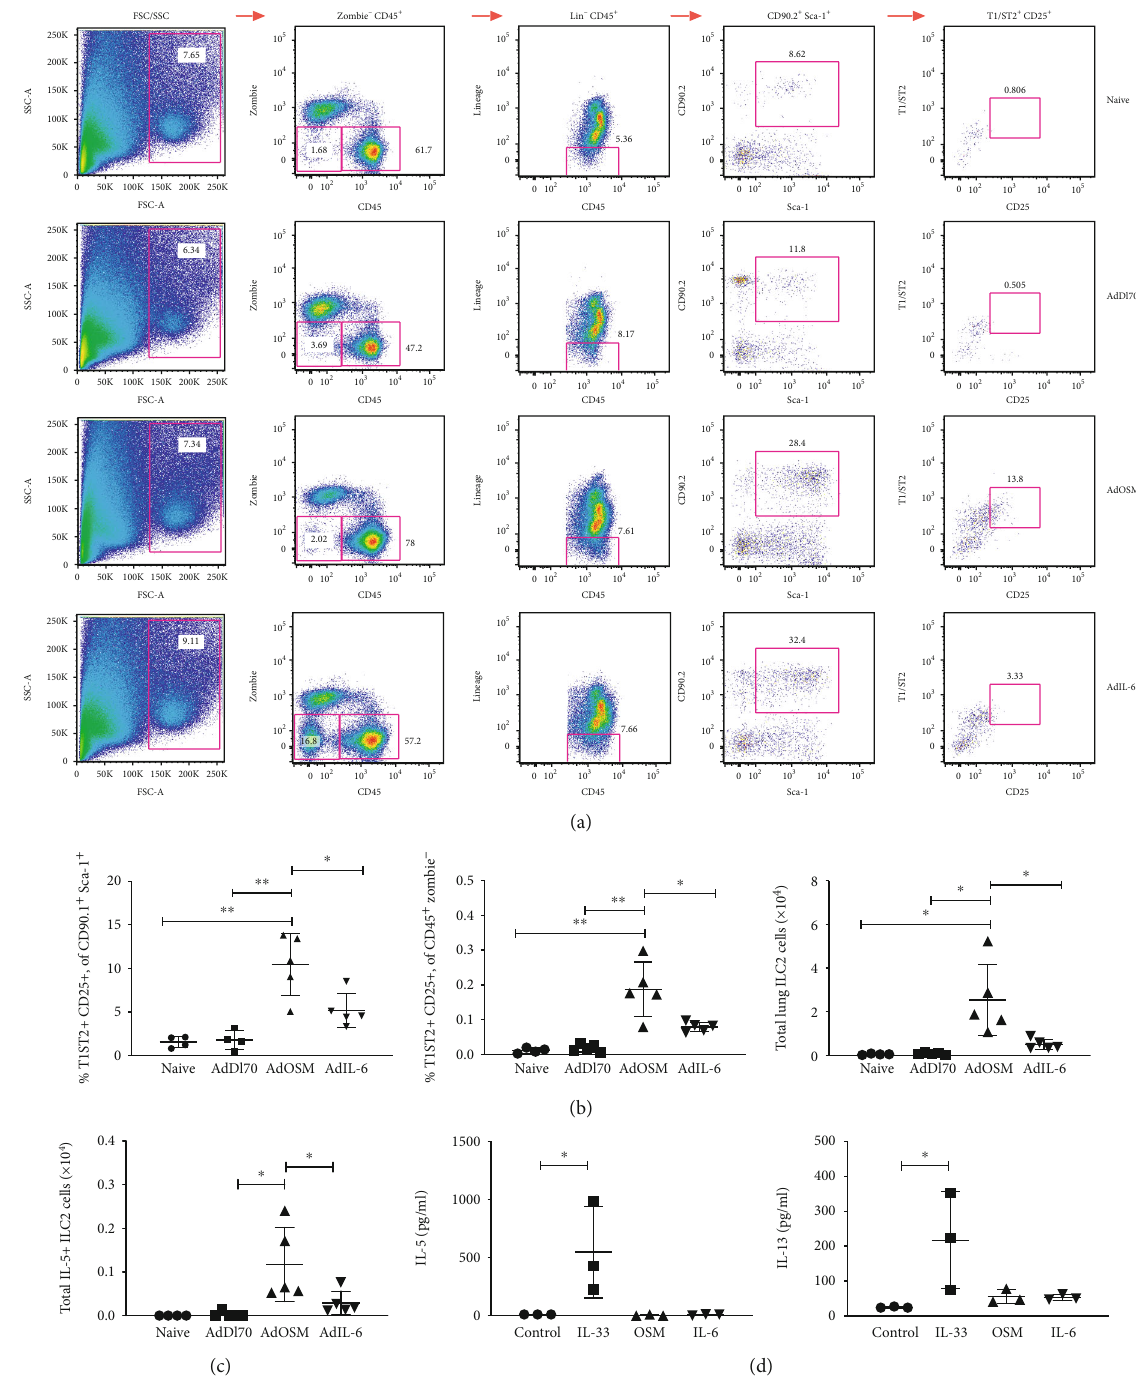
Figure 5: AdOSM, but not AdIL-6, stimulates accumulation of CD25+ T1/ST2 ILC2 cells. C57Bl6 mice were endotracheally administered AdDl70 (control), AdOSM, or AdIL-6, sacri fi ced at day 7, and ILC2 cell accumulation examined by fl ow cytometry of whole lung cells. ILC2 cells were assessed by fl ow cytometry as being lineage-negative (CD3-, CD19-, NK1.1-, Ter119-, CD11b-, and F4/80-), CD45+, CD90.2+, Sca-1+, and T1/ST2+ (IL-33R) cells that expressed varying levels of CD25. (a) Representative fl ow cytometry plots showing gating strategy for detecting T1/ST2+ CD25+ ILC2 cells from naive, AdDl70, AdOSM, or AdIL-6 infected mice. (b) Frequency of T1/ST2+ CD25+ CD90+ Sca-1+ parent and T1/ST2+ CD25+ CD45+ Zombie- cells, and total lung cell numbers of T1/ST2+ CD25+ ILC2 cells in the mouse lungs of naive and adenoinfected animals. (c) Total IL-5+ T1/ST2 CD25+ ILC2 cells from mouse whole lung. (d) Flow cytometry-sorted ILC2 cells from naive mouse lungs were stimulated in vitro with IL-2 alone (control) or in combination with IL-33, OSM, or IL-6 and assessed for IL-5 or IL-13 from supernatants by ELISA. One-way ANOVA with Tukey ’ s multiple test. ∗ p < : 01 , ∗∗ p < : 001 . N = 3 ‐ 5/group